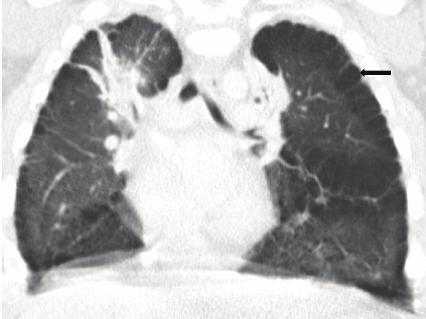
Figure 1: Coronal view of the chest CT shows diffuse subpleural cysts (block arrow) of both lungs along the chest wall and the major fissure of lungs bilaterally.